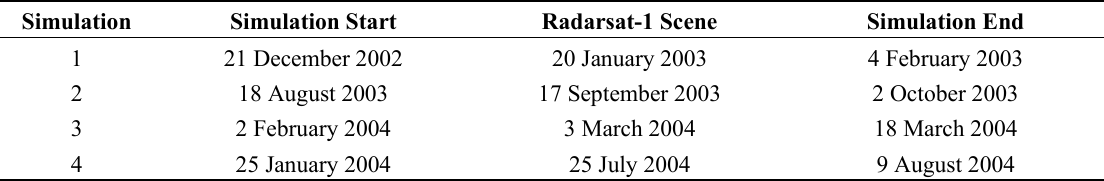
Table 2. Simulation time period